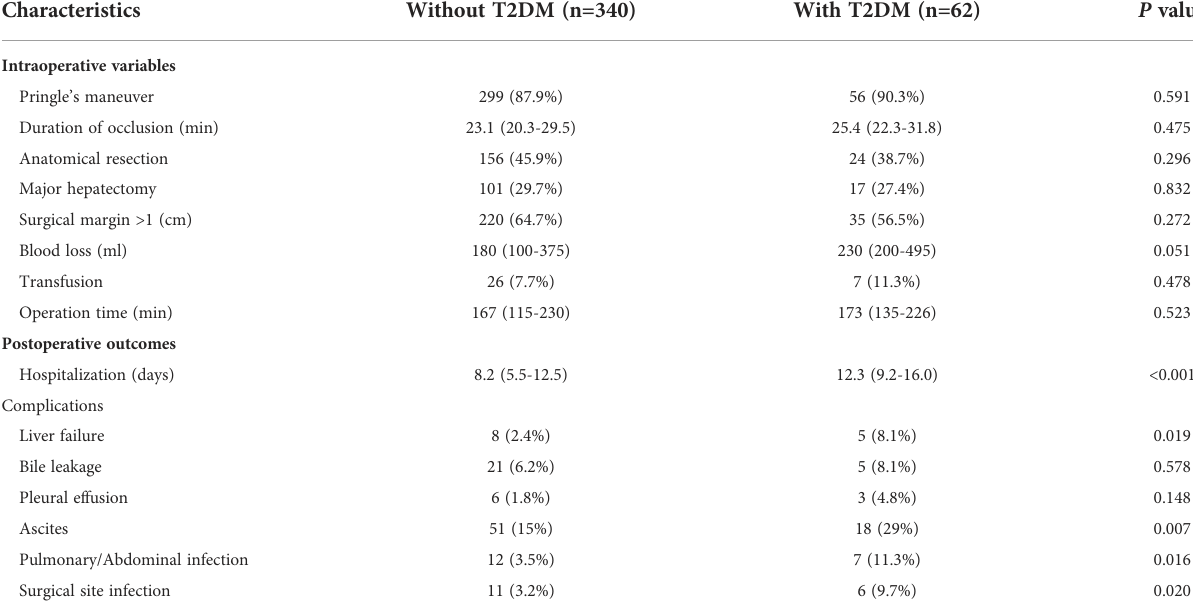
TABLE 3 Intraoperative variables and Postoperative short-term outcomes of all HCC patients (n=402). Characteristics